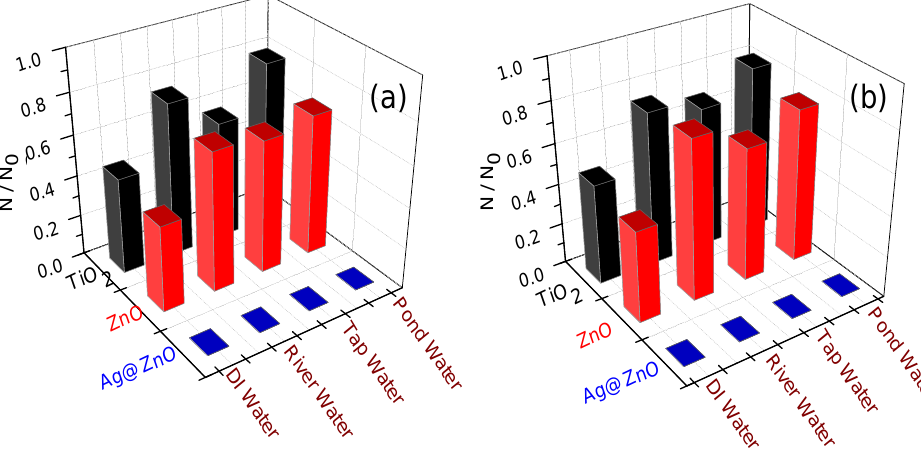
Figure 9. Effect of different photocatalysts on the relative reduction in the ( a ) E. coli and ( b ) S. aureus cell count ( N/N 0 ) in real water samples after 120 min of solar irradiation at a catalyst loading of 2 mg/L and 3 mg/L catalyst concentration, respectively. In each case the initial bacteria concentration = 5 × 10 6 CFU/mL, Temperature = 35 ± 2 °C.